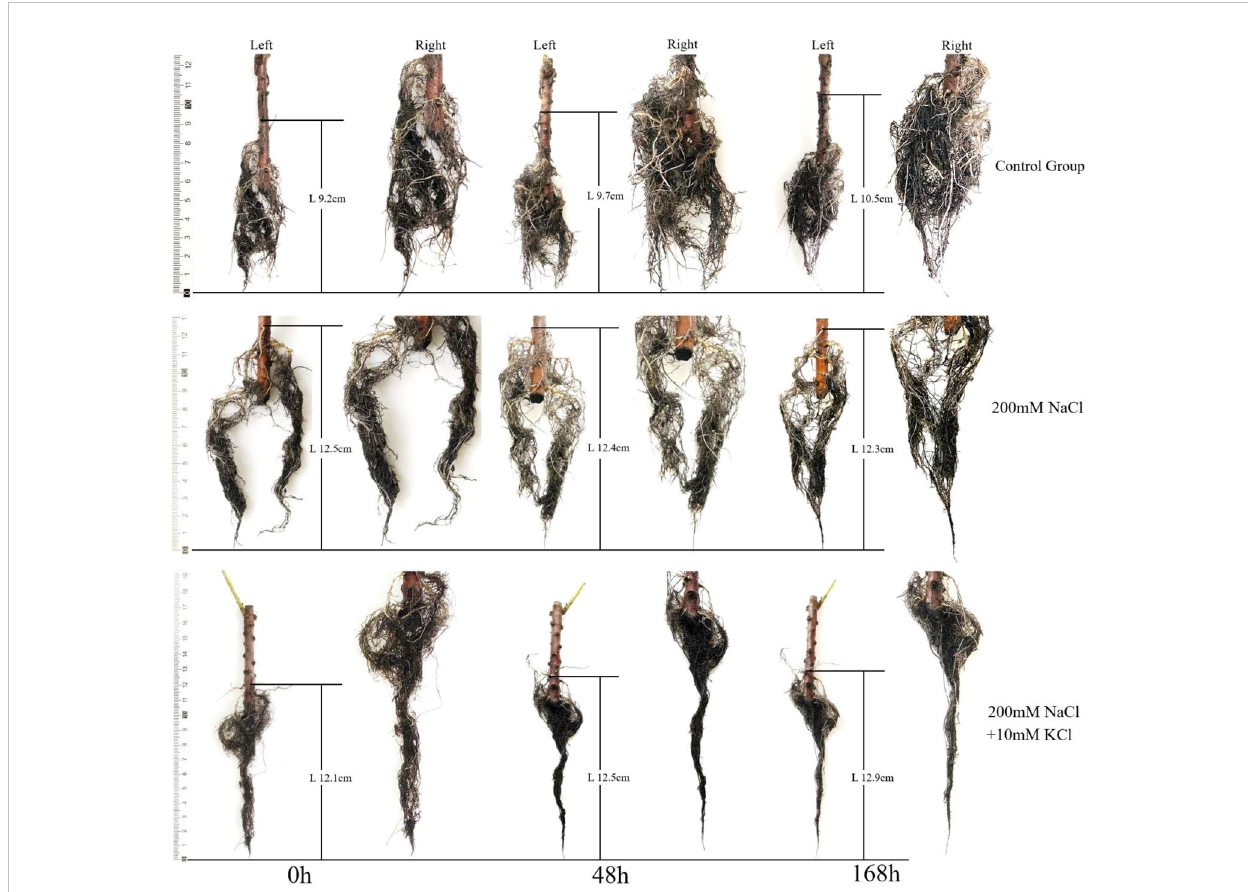
FIGURE 1 Change of roots growth of T. ramosissima under exogenous K + application under NaCl stress. (Changes of the roots ’ length of T. ramosissima in the control group and different treatments at 0h, 48h and 168h. The left is the original image, and the right is the zoomed